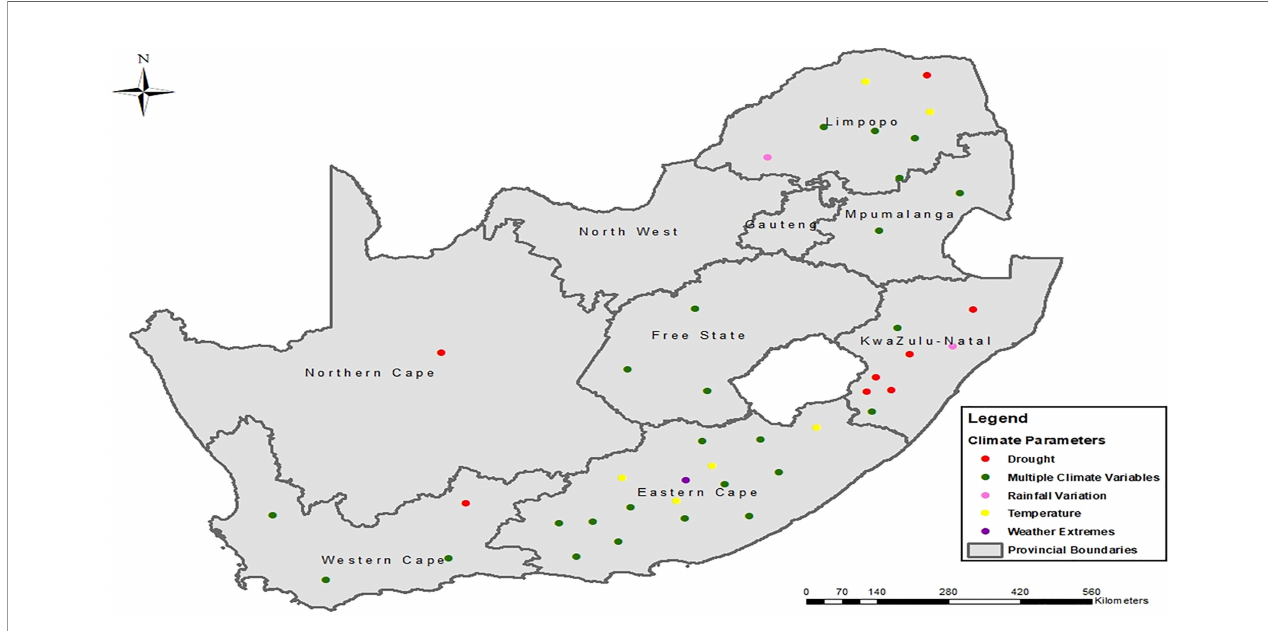
FIGURE 4 | Provincial distribution of research conducted on climate change risks to livestock production in rural communities of South